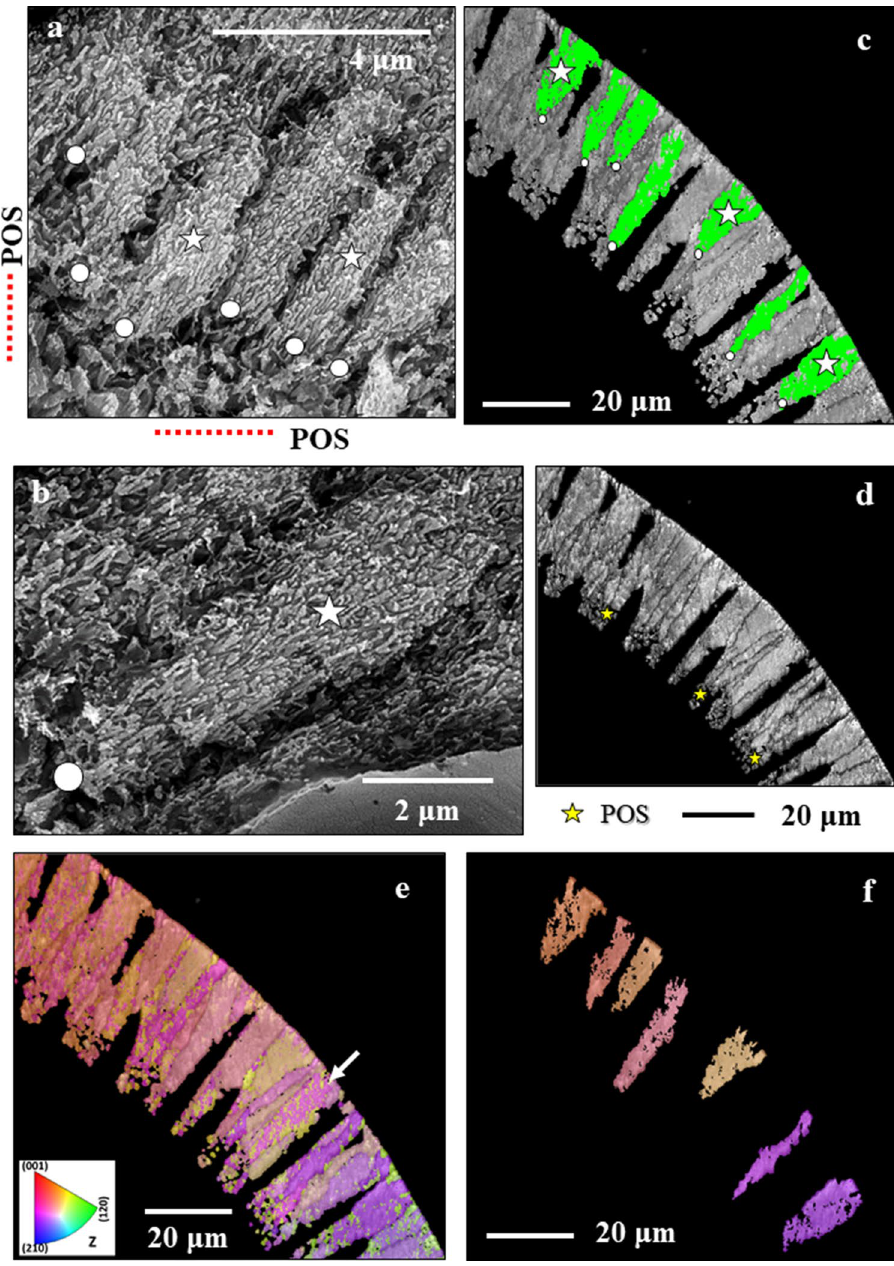
Figure 5. The crystals and crystal units in the shell of Pulleniatina obliquiloculata. ( a ) and ( b ) BSE images of elongated, sheaf-like crystals (white stars). These start to form at the POS (white dots in ( a ) and ( b )) and comprise most of the cone-shaped calcite entities ( c ), ( d ), ( f ). ( c ) and ( d ) EBSD band contrast images in grey visualizing the extent of the cone-shaped units; ( c ) highlighted in green are some, arbitrarily chosen, cone- shaped crystals. ( e ), ( f ) calcite crystal orientation obtained from EBSD, for ( e ) an entire shell wall section and ( f ) the selected cone-shaped units that are shown in ( c ). From the uniformity in color it is evident that the calcite within the cone-shaped units have uniform crystallographic lattice